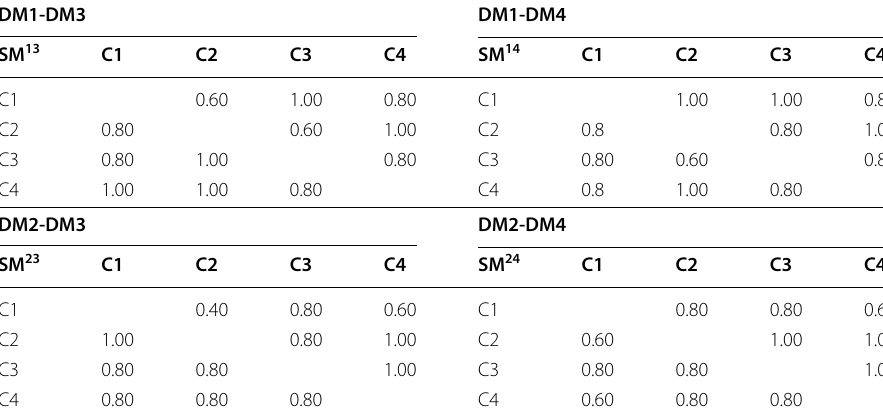
Table 8 Similarity matrixes for revenue sharing model